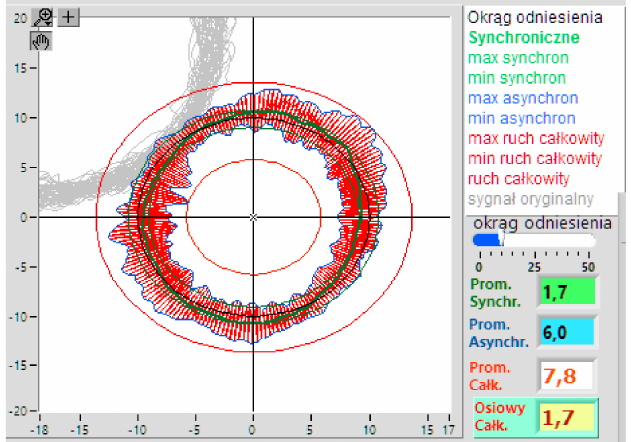
Figure 5. A polar diagram of error movements in the radial